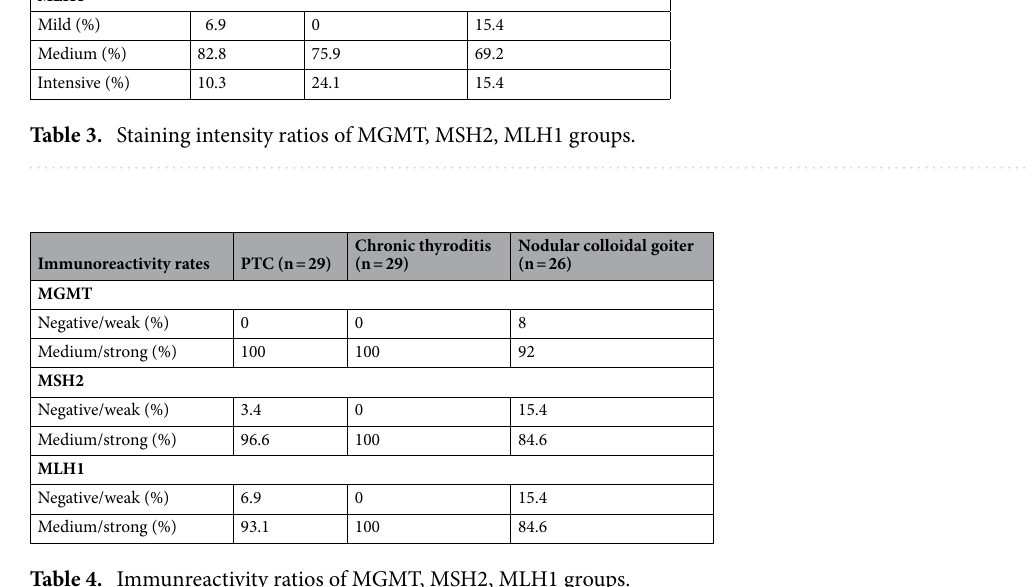
Table 4. Immunreactivity ratios of MGMT, MSH2, MLH1 groups.